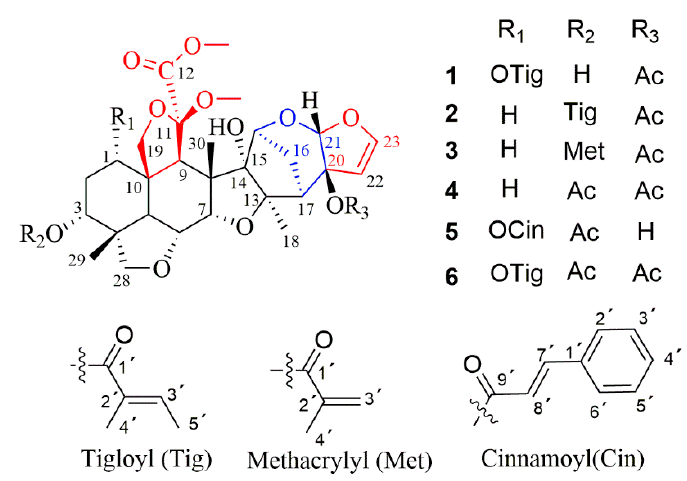
Figure 1. Chemical structures of limonoids 1–6.